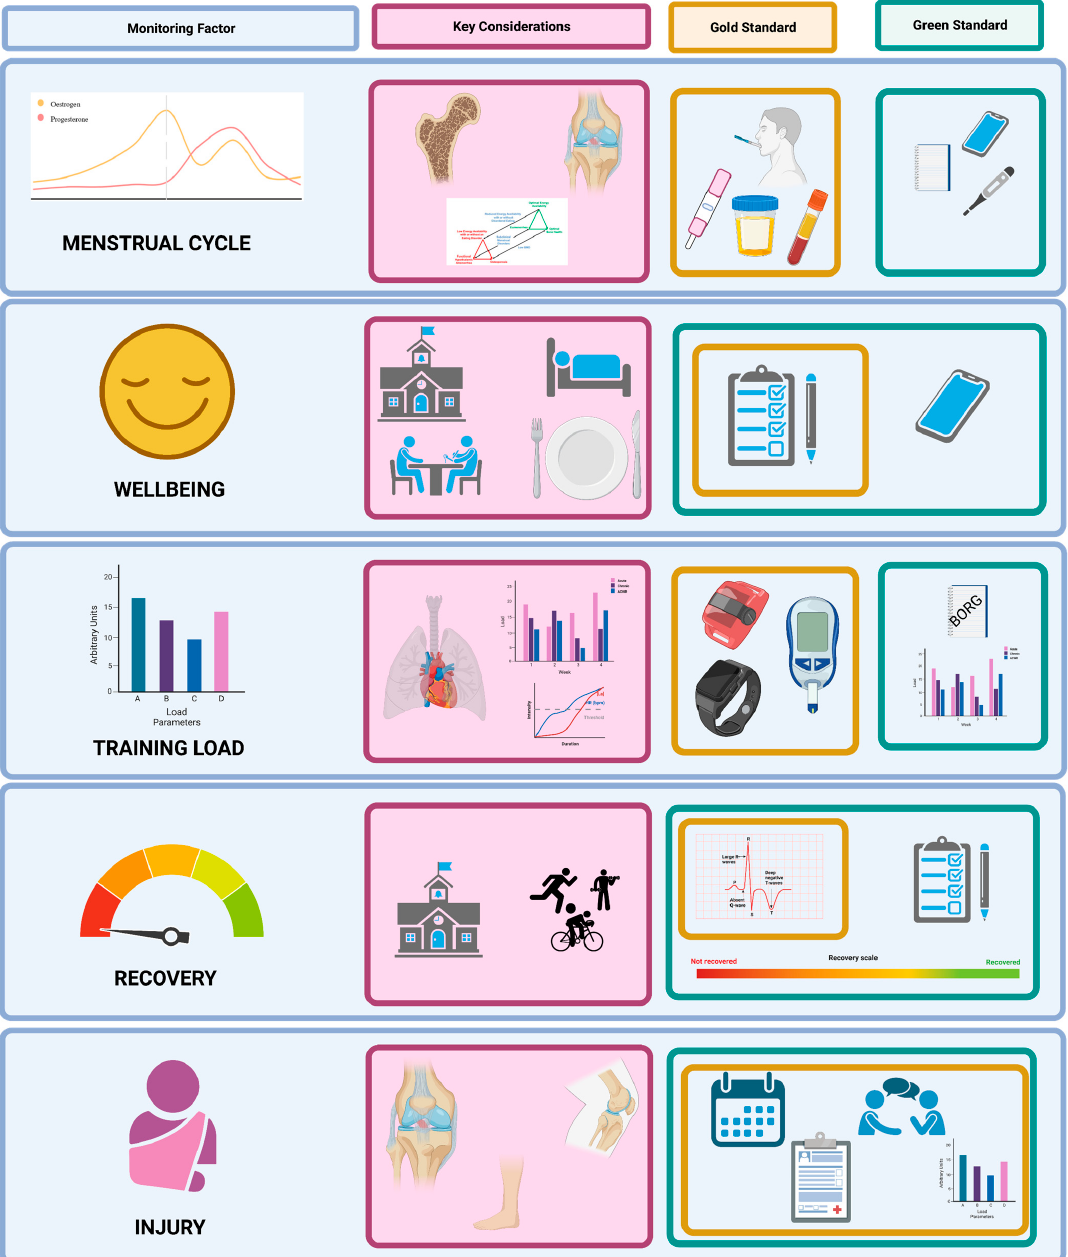
Figure 2. Monitoring factors, their respective key considerations in youth female athletic populations and gold and green standard monitoring practices for each factor. Note that some tools can be used to monitor multiple factors simultaneously, or will be used at differing monitoring intervals to provide contextual depth of understanding. Gold and green standards may overlap when low-cost options are reliable and valid measures of the monitoring factor under